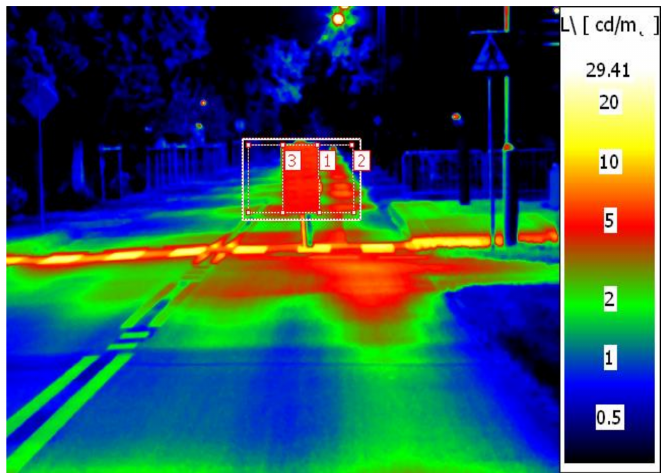
Figure 18. Luminance distribution for example position of the board at crossing no. 2.